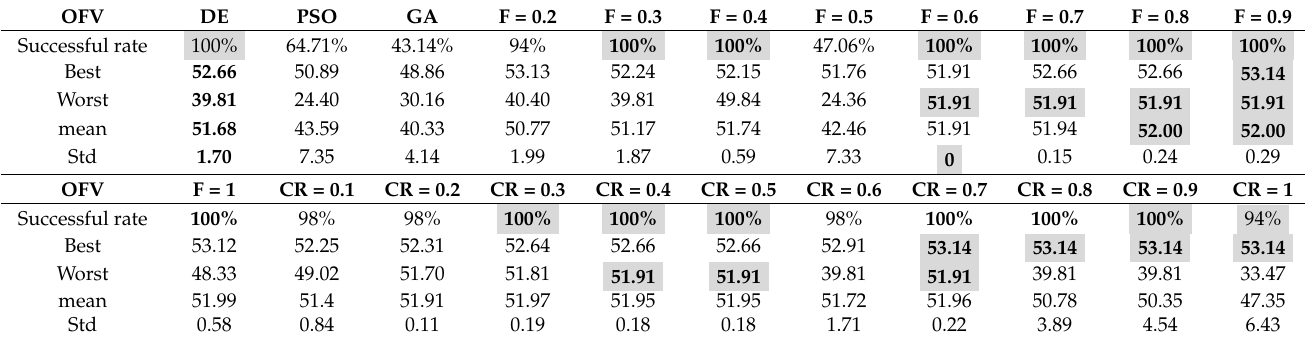
Table 4. Comparison of DE, PSO and GA within 51 independent